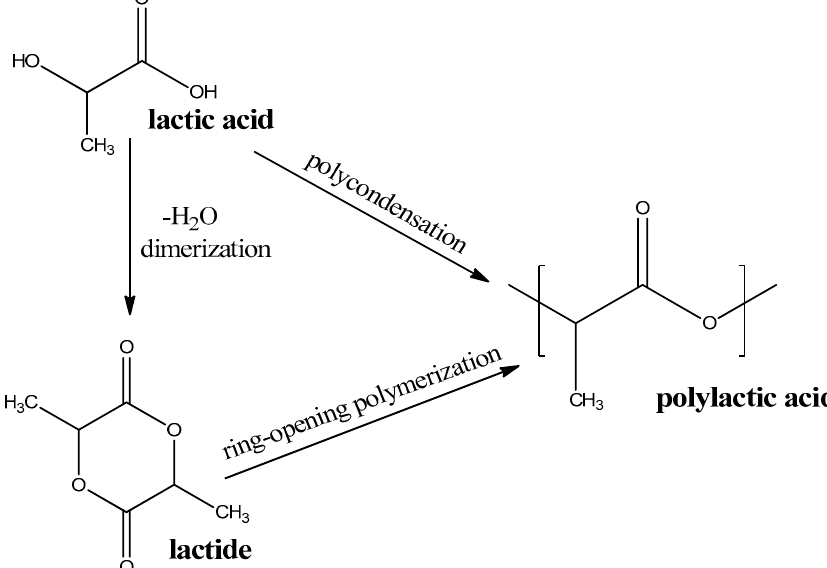
Figure 4. Synthesis routes PLA.